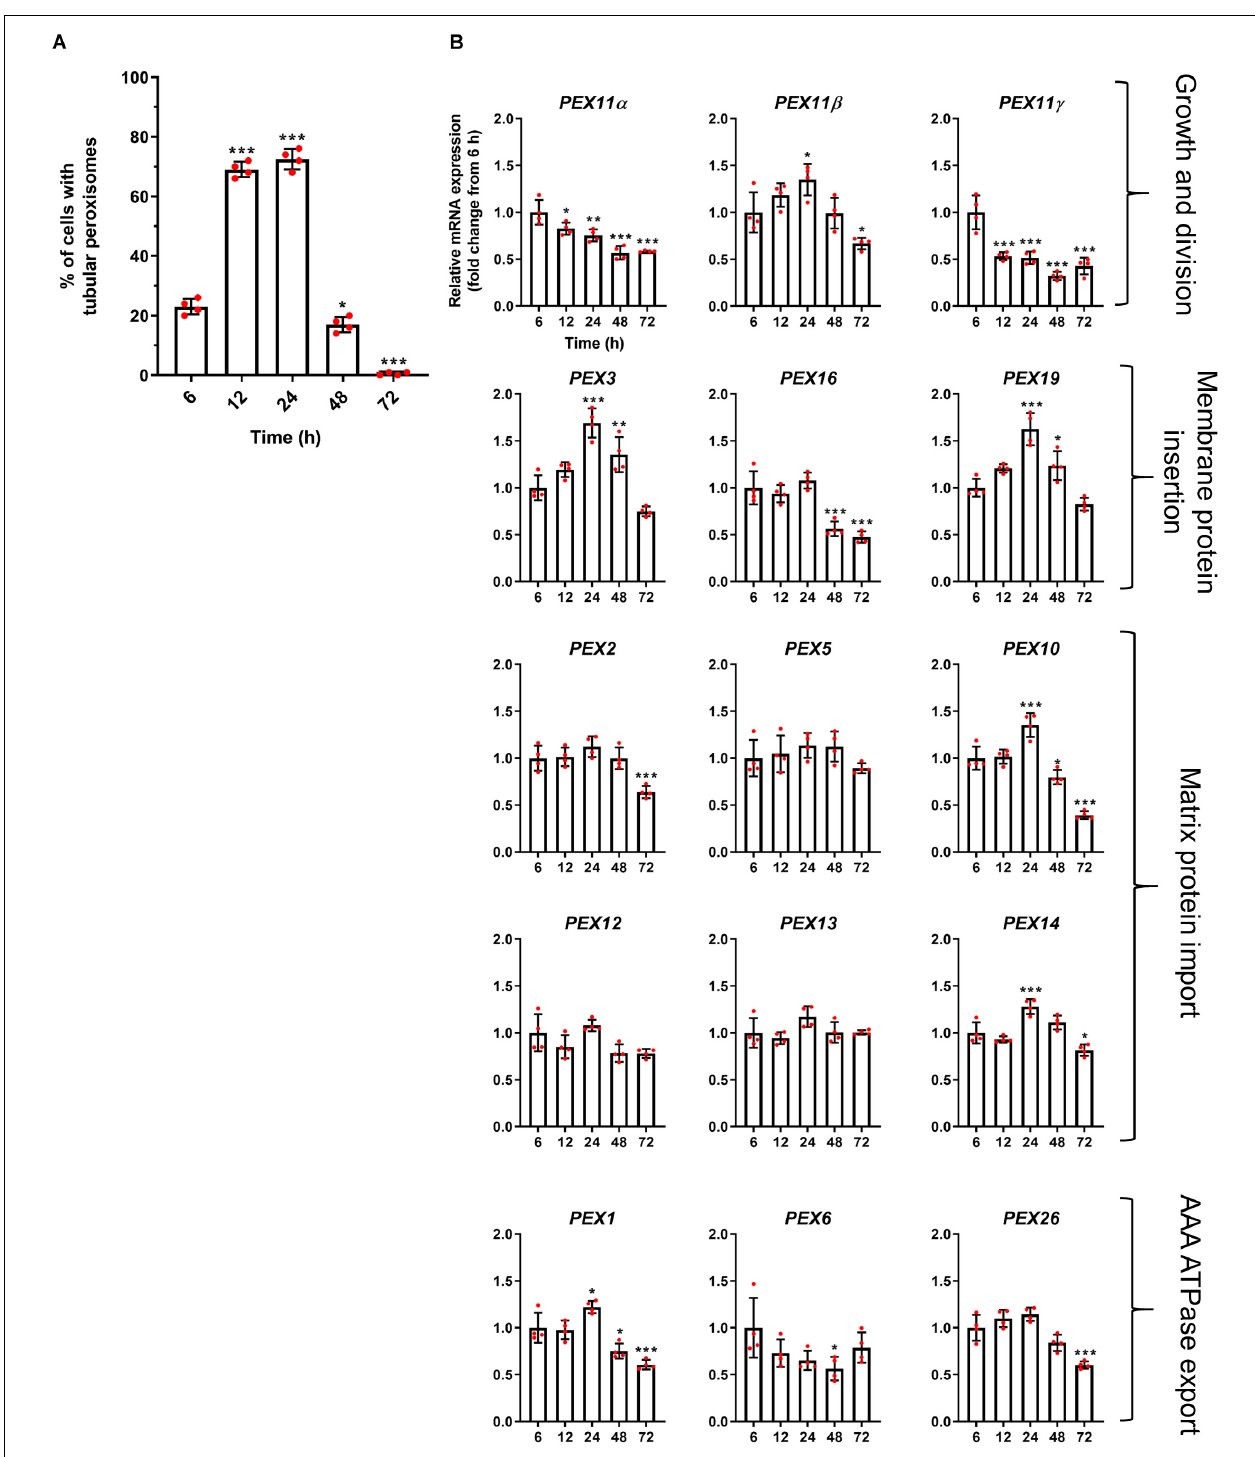
FIGURE 3 | Correlation of peroxisome morphology and mRNA abundance profiles of PEX genes in HepG2 cells during a time course. (A) Quantitative analysis of tubular peroxisomes in HepG2 cells monitored over time in MEM/FBS and processed for immunofluorescence. Data from 4 independent experiments ( n = 300 cells in each condition); analyzed by one-way ANOVA with Dunnett’s post hoc test. (B) qPCR analysis of relative mRNA levels of a set of PEX genes normalized to 18S rRNA expression over time. Note that PEX11 β mRNA levels correlate with the proportion of cells showing tubular peroxisome morphology, emphasizing its role in peroxisome elongation and division. In contrast, PEX11 α mRNA levels do not correlate with changes in peroxisome morphology. Data from 4 independent experiments; analyzed by one-way ANOVA with Dunnett’s post hoc test; * p < 0.05, ** p < 0.01, *** p < 0.001.